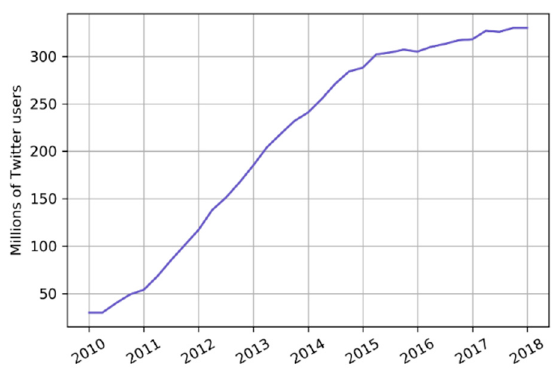
Figure 1. The figure shows the number of Twitter users active globally.